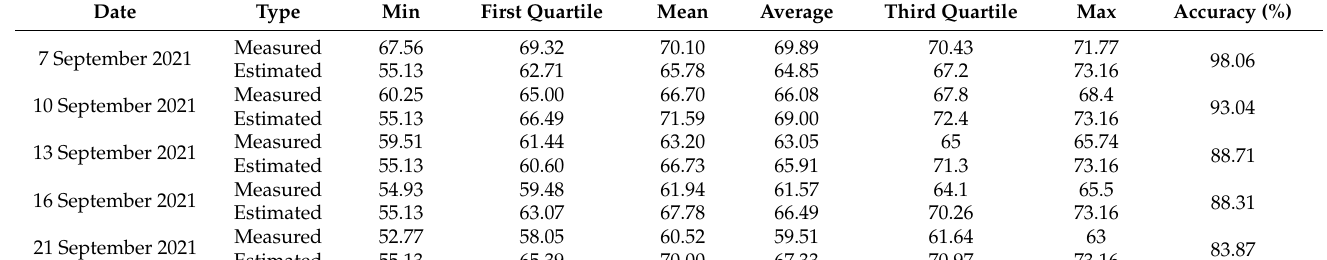
Table 3. Accuracy of the average correlation coefficient (measured tension vs. estimated tension).